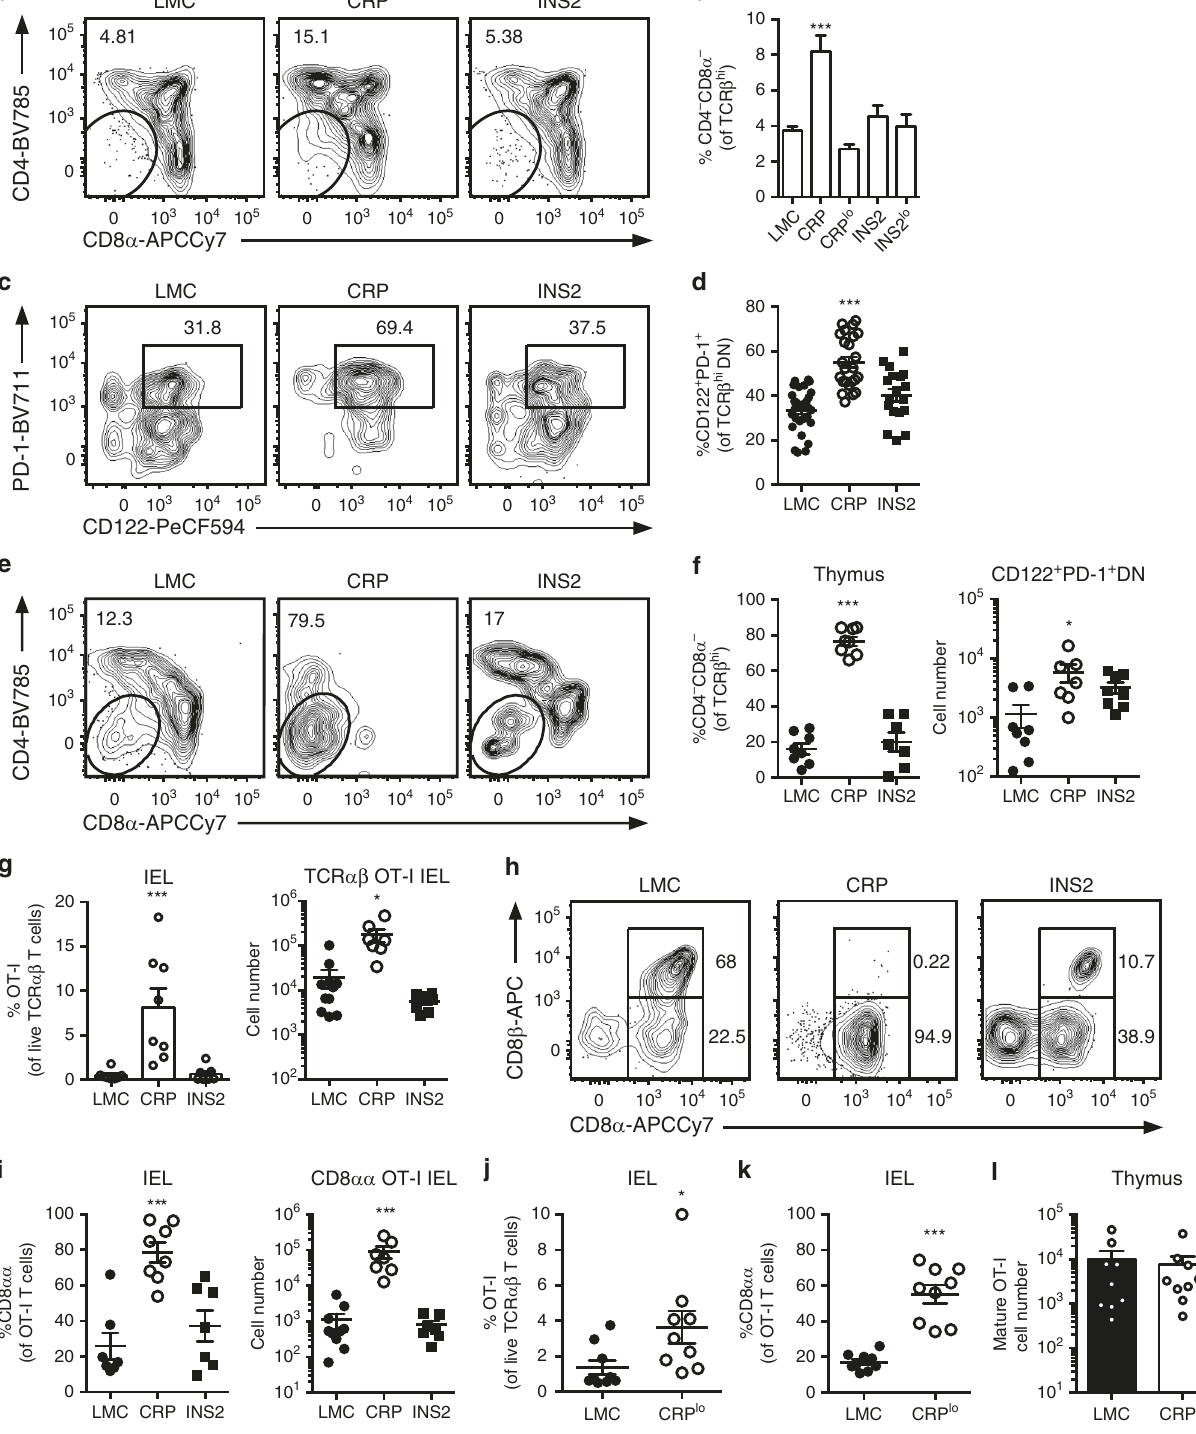
increased proportion of model antigen-speci fi c CD25 + Foxp3 + T reg relative to LMC (Fig. 5h, i). However, the relative absolute number of gp66-speci fi c CD25 + Foxp3 + T reg is not increased in INS2 Tg mice as compared to LMC (Fig.